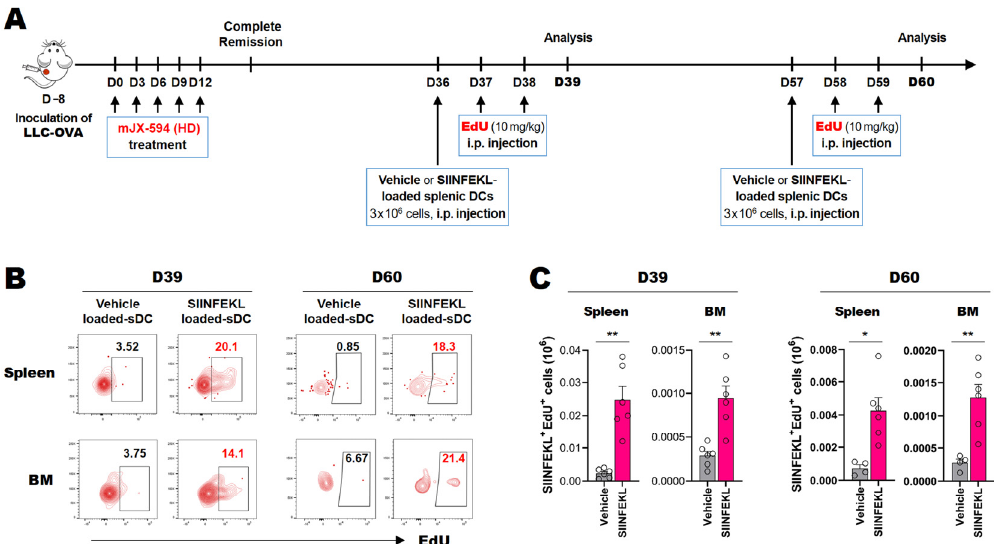
Figure 6. Long-lived cancer neoantigen-specific CD8 + T cells proliferated in response to antigen- loaded dendritic cells in situ. ( A ) Schematic representation of the experimental schedule. LLC-OVA cells were subcutaneously implanted into C57BL/6 mice. When the tumor volume reached 50–60 mm 3 , the mice were intratumorally injected with 5 × 10 7 pfu mJX-594 five times at 3-day intervals. Intraperitoneal injection of 3 × 10 6 splenic dendritic cells (sDCs) that had been loaded with either vehicle or 100 nM SIINFEKL on day 36 or day 57 of the first mJX-594 injection. In vivo proliferation of cancer neoantigen-specific memory-like CD8 + T cells in response to antigen-loaded sDCs was measured by incorporation of EdU (10 mg/kg) after labeling the cells twice (once per day on day 1 and day 2 before analysis) and analyzed by K b -SIINFEKL dextramer staining and Click-iT™ EdU Flow Cytometry Assay Kit (K b -SIINFEKL + EdU + ). ( B , C ) Representative flowcytometric plot ( B ) and absolute number ( C ) of proliferating EdU + cells among K b -SIINFEKL dextramer-positive cells. Pooled data from two experiments are shown ( n = 4–6 per group). * p < 0.05, ** p < 0.005.